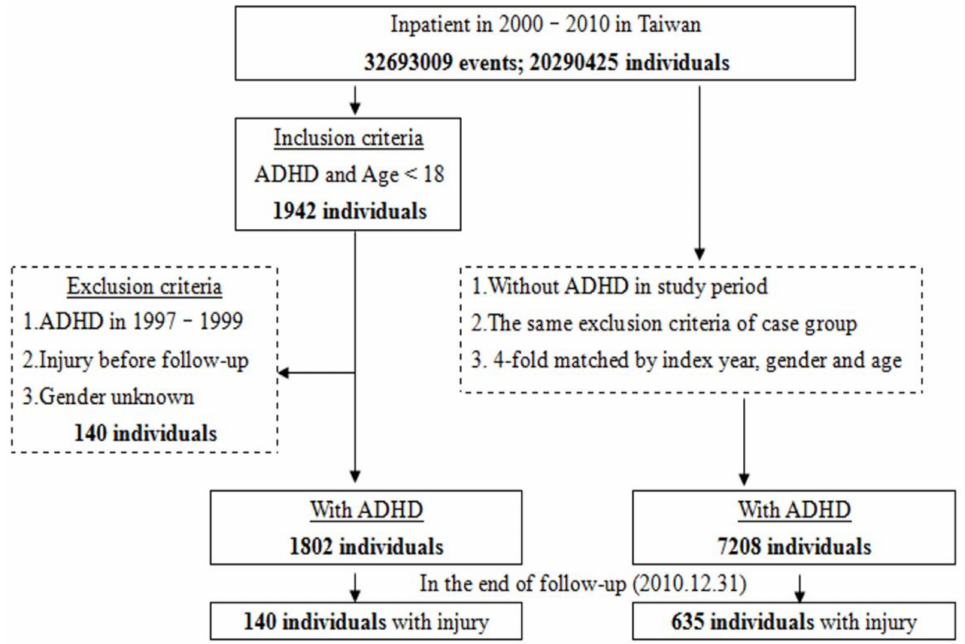
Figure 1. The flowchart of study sample selection from National Health Insurance Research Database in Taiwan. Note: ADHD = attention-deficit hyperactivity disorder: ICD-9-CM 314 Injury: ICD-9-CM